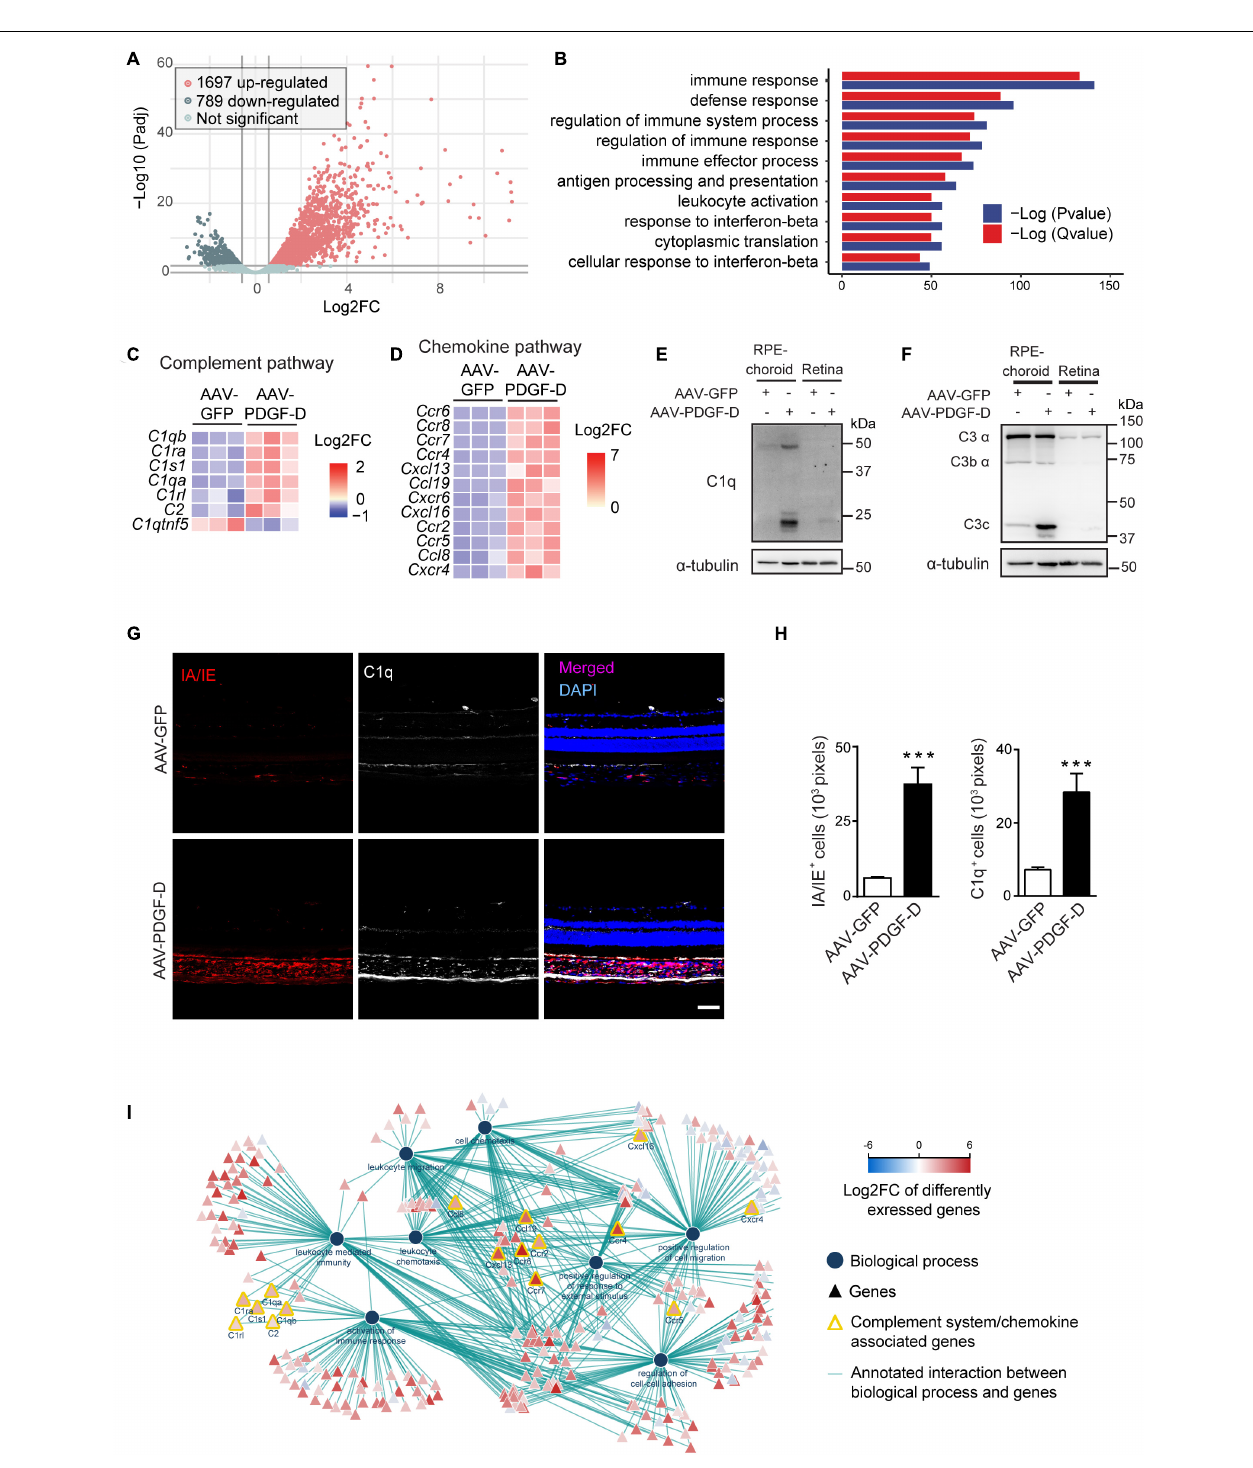
FIGURE 3 | RNA-seq and transcriptomic analysis of PDGF-D-induced complement pathway. (A) Volcano plot showing the differentially expressed genes (DEFs) from the RNA-seq data. (B) Biological function enrichment gene ontology (GO) analysis of DEGs showing the enriched biological processes in mouse PDGF-D-overexpressing RPE-choroids. (C,D) Heatmap of the DEGs associated to complement pathway (C) and chemokines and chemokine receptors (D) in mouse RPE-choroids injected with AAV-GFP or AAV-PDGF-D. (E,F) Immunoblot of C1q (E) and C3 (F) expression in RPE-choroid complex and retinae from mice with AAV-GFP or AAV-PDGF-D injection. (G) Immunofluorescence staining showing the IA/IE and C1q expression in mouse retinae and choroids with AAV-GFP or AAV-PDGF-D injection. (H) Quantification of IA/IE and C1q expression in (G) . (I) Functional network analysis of DEGs showing pathways related to activation of the complement system, immune cell migration and activation of immune responses in PDGF-D-overexpressing RPE-choroids. Scale bar: 50 µ m. n = 5–6, *** p < 0.001.